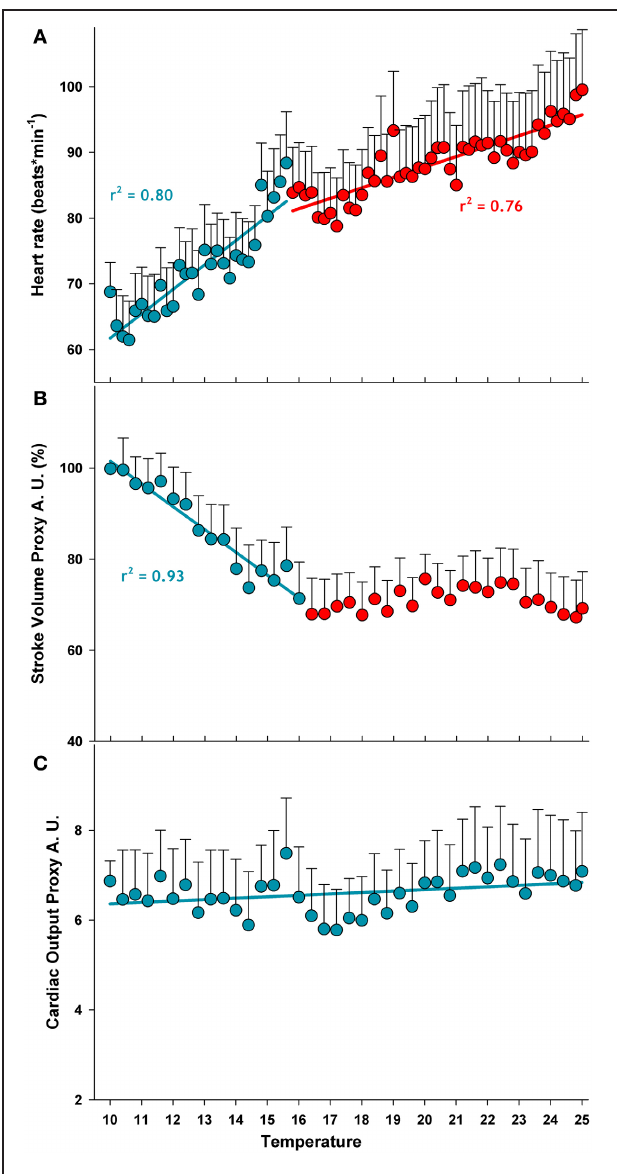
FIGURE 2 | Temperature dependent pattern of cardiac activity during acute warming from 10 to 25 ◦ C. The two colors represent the discontinuities in the temperature dependence of heart rate and SVP data (means) analyzed from linear regressions, intersecting at the respective breakpoints. Regressions for heart rate data (panel A ) are: y ( 10 − 15 . 6 ◦ C ) = = ( 56 . 0 ± 2 . 7 ) + ( 24 . 6 ± 4 . 6 ) + ( 3 . 717 ± 0 . 345 ) x , p < 0 . 0001; y ( 15 . 8 − 25 ◦ C ) ( 1 . 590 ± 0 . 131 ) x , p < 0 . 0001. Regressions for SVP (panel B ) are y ( 10 − 15 . 6 ◦ C ) = ( 151 . 6 ± 5 . 4 ) + ( − 5 . 011 ± 0 . 417 ) x , p < 0 . 0001; y ( 16 − 25 ◦ C ) = n . s. The discontinuities in the slopes are at 15.6 ◦ C, for both parameters. The regression for the cardiac output proxy (heart rate x SVP) (panel C ) was not significant, indicating that cardiac output was constant over the whole temperature range. Data are means ± s.e.m., n = 11.